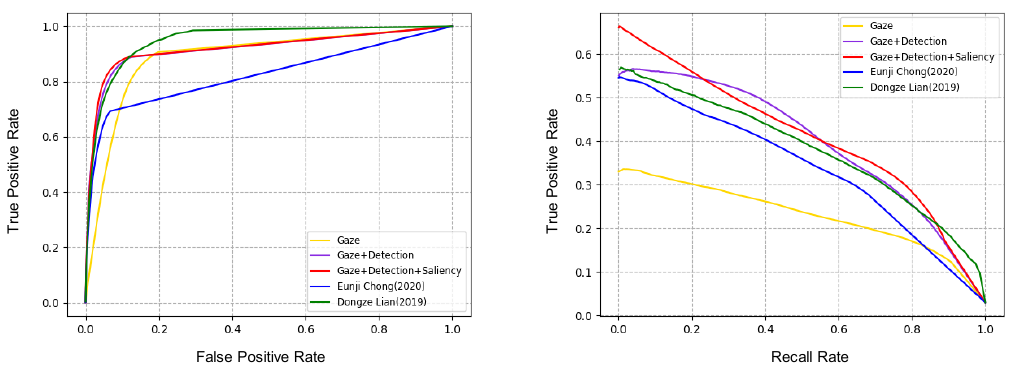
Figure 5. ROC curves ( left ), PR curves ( right ). Table 1. PR and ROC values between different methods.